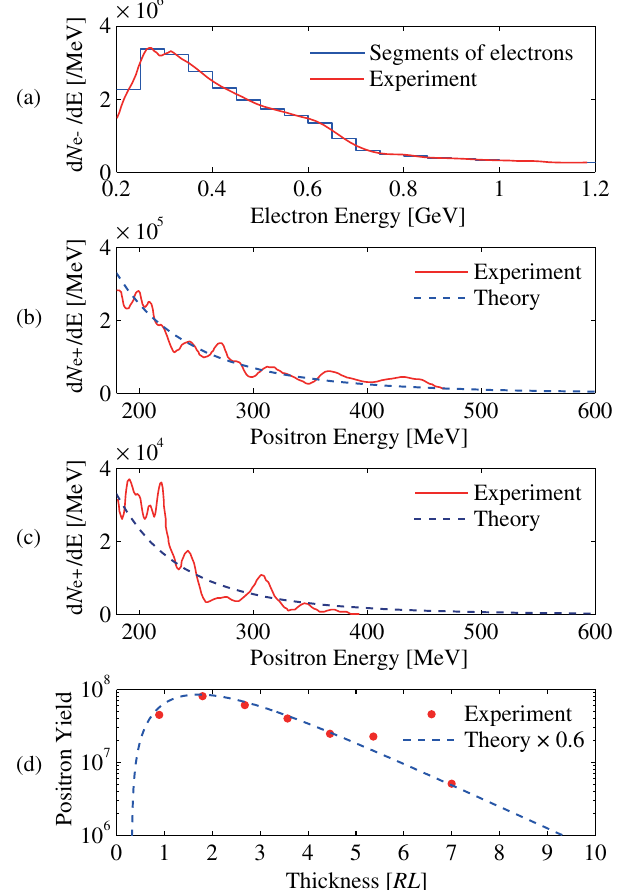
FIG. 4. Comparison of positron spectrum and total yield obtained in experiment and calculated by our theoretical ex- pressions. Experimental results come from Ref. [12]. In the calculation, the experimental electron spectrum [red curve in (a)] was divided into 20 segments [blue curve in (a)]. (b) and (c) show the positron spectra (energy > 120 MeV) from experiment (red lines) and theory (blue dash lines) for different converter thick- ness 2 cm (3.48 RL ) and 4 cm (6.96 RL ). (d) shows the measured (red dots) and calculated (blue dash line) total yields as a function of converter thickness.